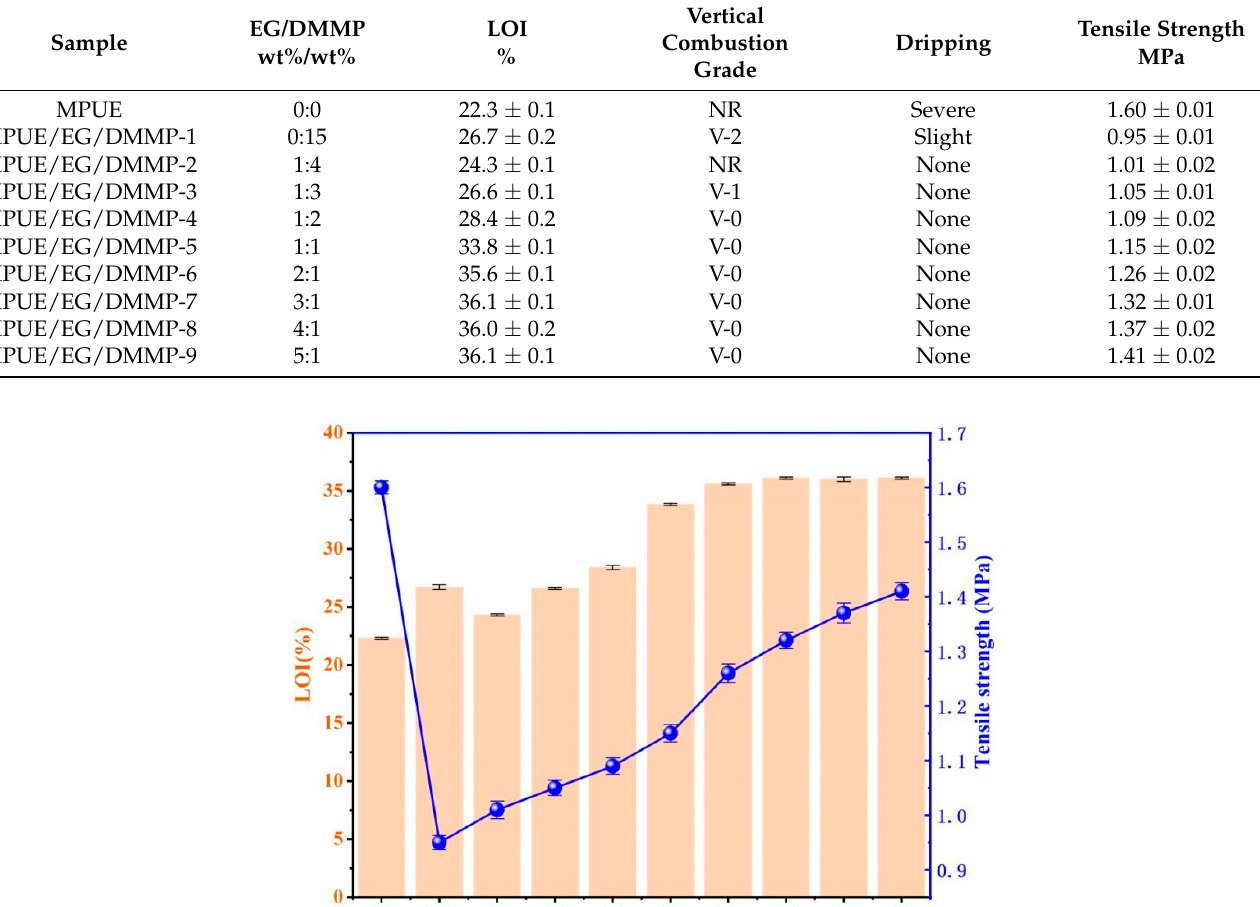
Table 5. Effect of EG/DMMP with different ratios on the overall properties of MPUE.